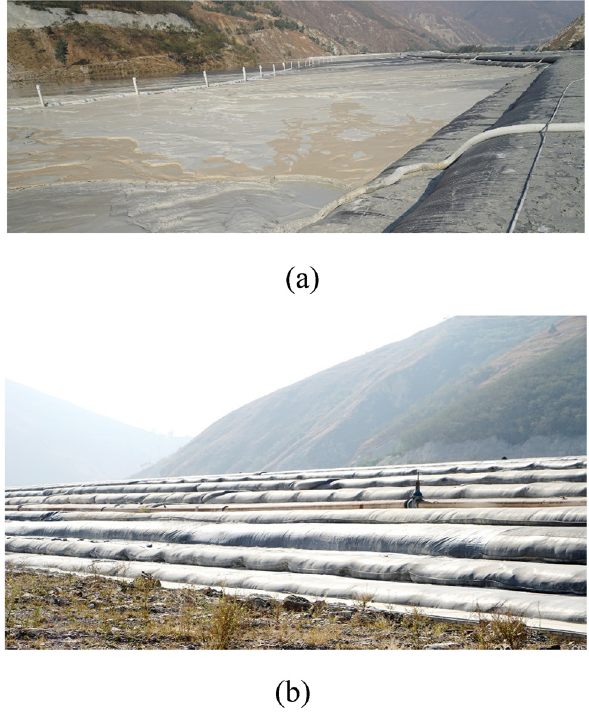
Figure 1: Zoomed - in partial view of tailings dam constructed with geotextile tubes in Yunnan province: ( a ) interior and ( b )